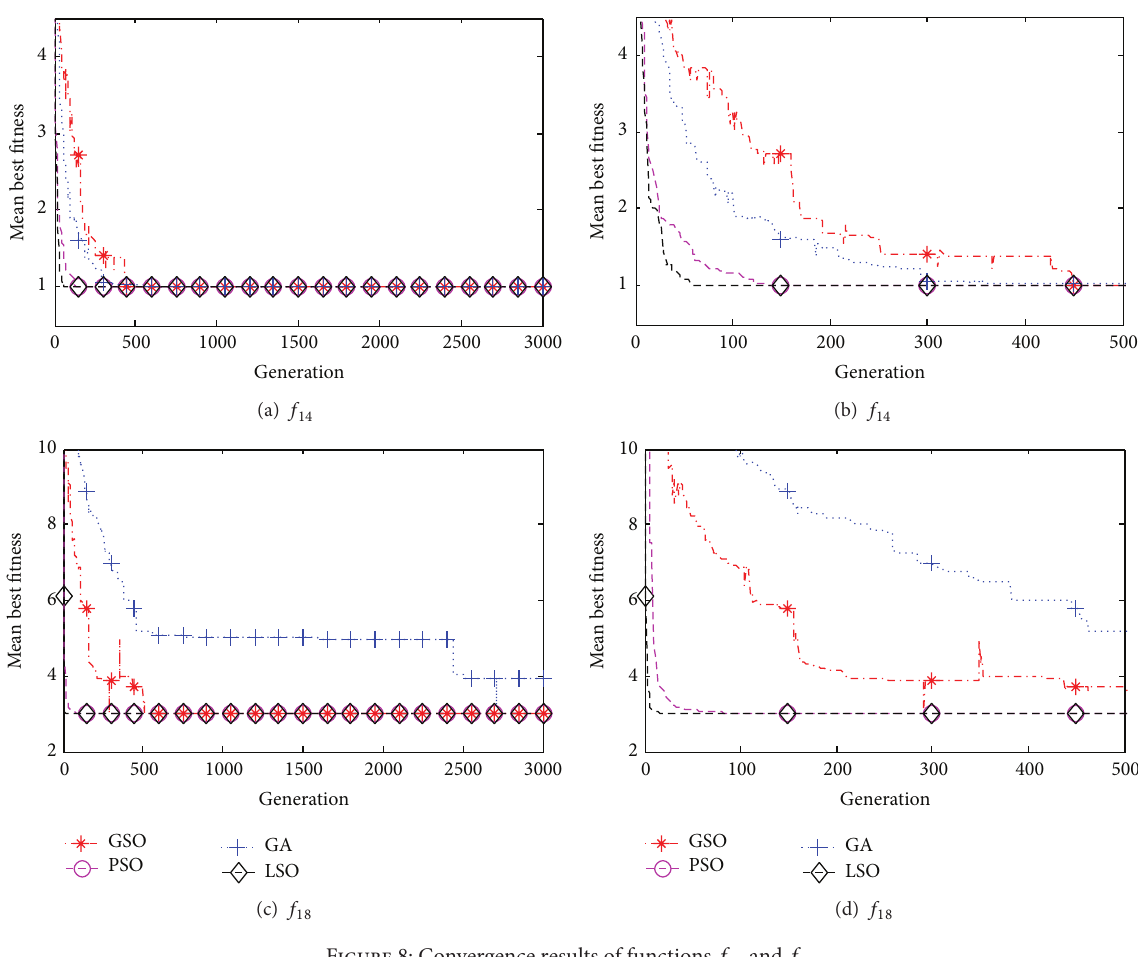
Figure 8: Convergence results of functions 𝑓 14 and 𝑓 18